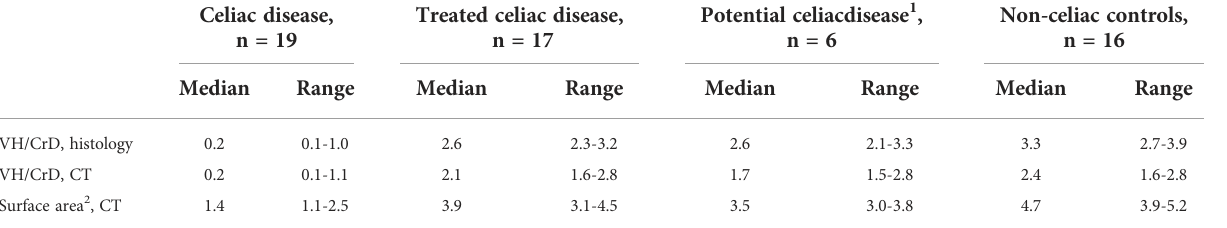
TABLE 2 Histological features and micro-CT fi ndings of the 58 study